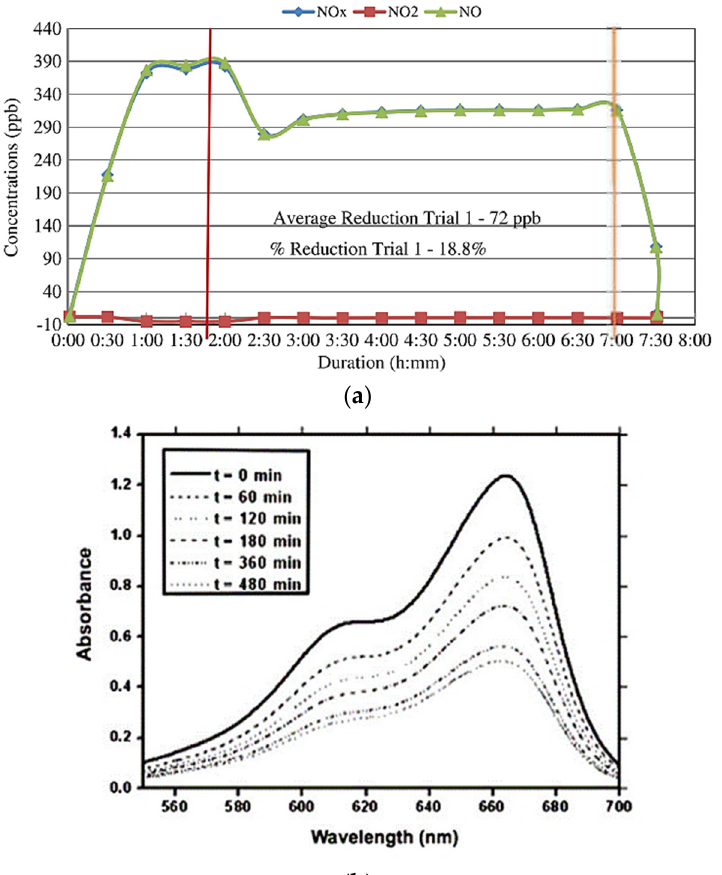
Figure 5. Results of photocatalytic tests: ( a ) variation (over time) of gas concentration, indicating its